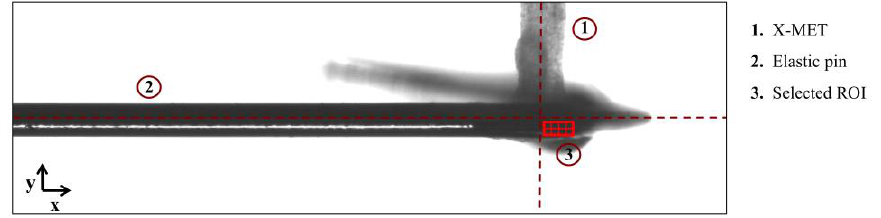
Figure 6. Example of an image acquired for the X-MET contractility measurement: magnification of 2X and resolution of 1020 × 300 pixels. The resulting ROI selected for image processing moved from the central axis between the X-MET and the elastic pin.